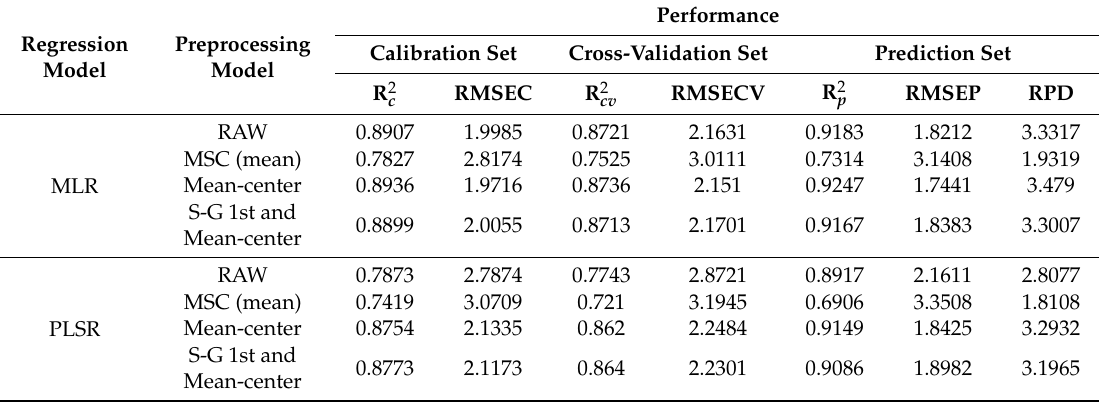
Table 5. Prediction performances of di ff erent regression models based on the electronic nose